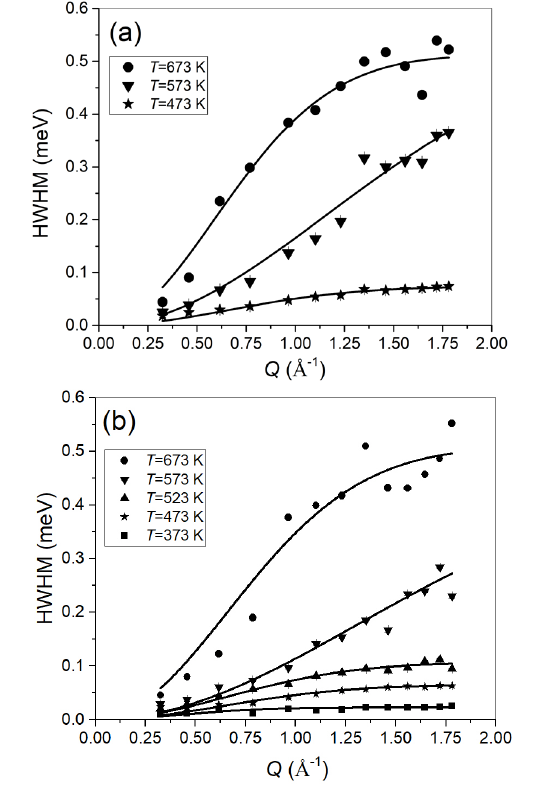
Figure 3. The half-width-at-half-maximum (HWHMs) for the 2 bar-loaded sample ( a ), and the 4 bar-loaded sample ( b ). Lines denote the fit with the mentioned Hall-Ross (HR) model.